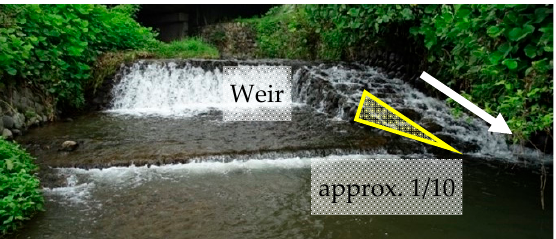
Figure 1. An example of a fishway with a longitudinal gradient greater than 1/20.